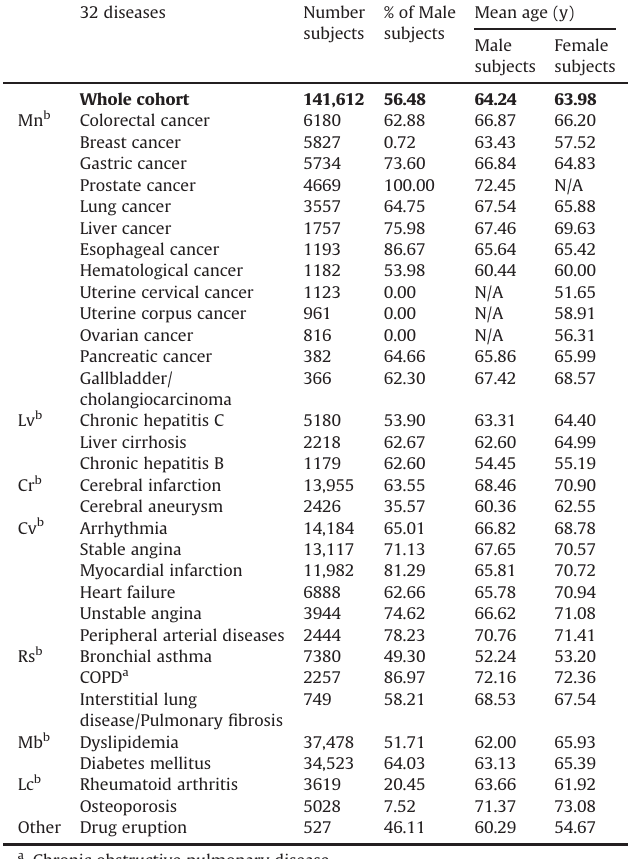
Table 1 Baseline characteristics of subjects with 32 diseases for follow-up